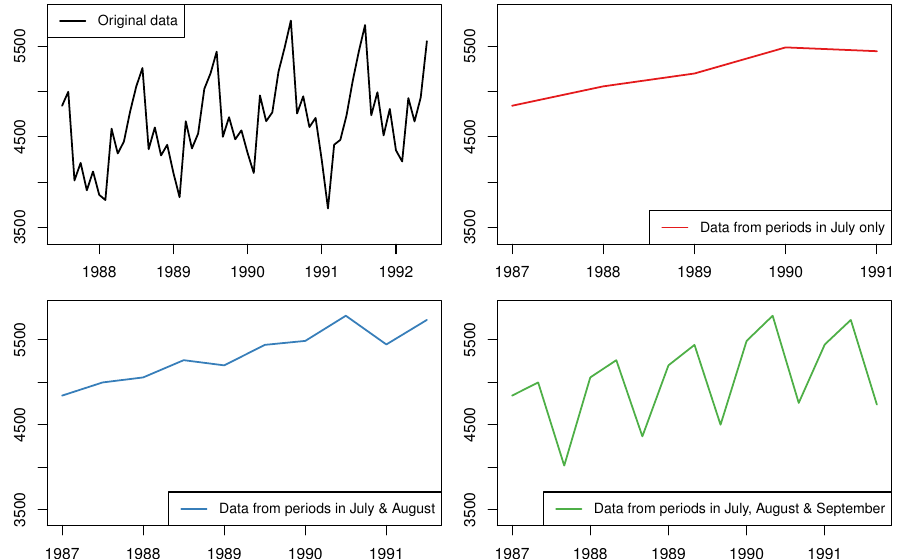
Figure 4. An illustrative example of producing sub-seasonal series by sub-sampling the original monthly data (first panel). In the second panel, we have produced a non-seasonal series that consists only of the periods in July of each year. The third and fourth panels show two more sub-sampled series with periodicity 2 and 3, respectively. Note that by considering particular subsamples, the level as well as other patterns change